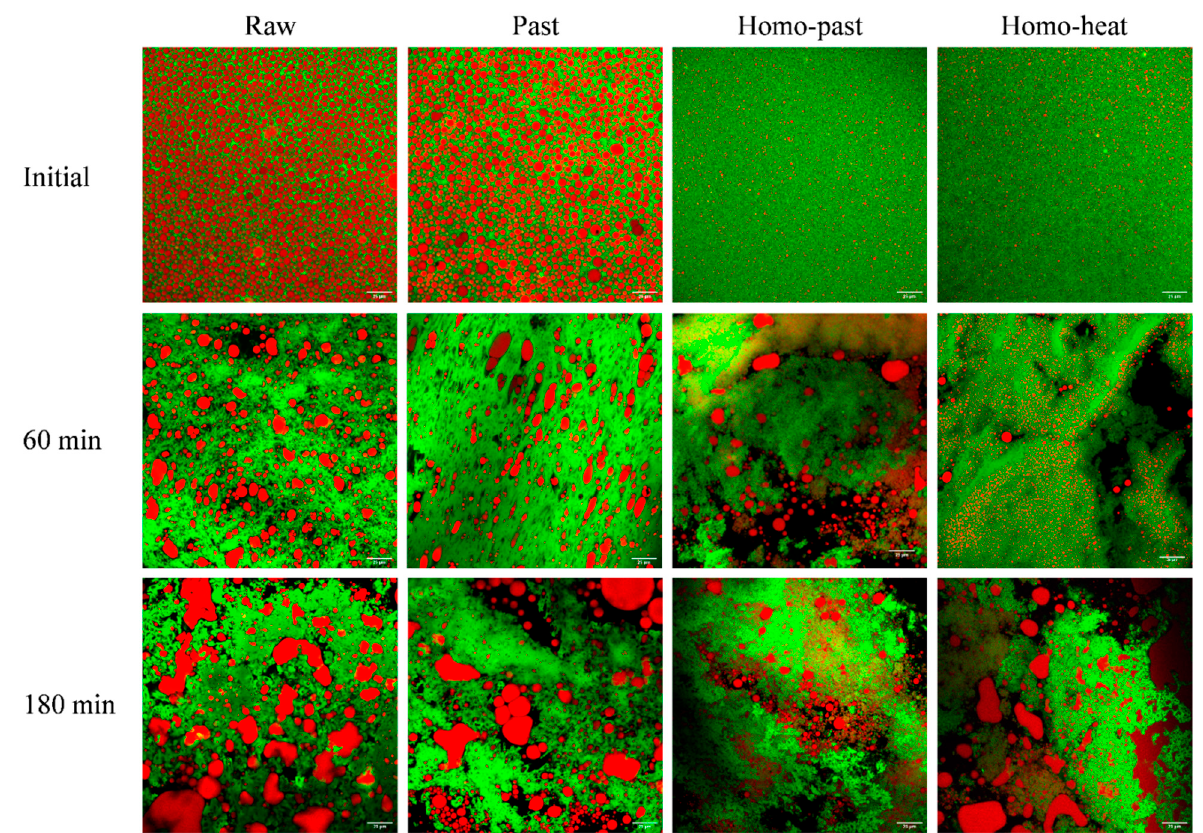
Figure 3. Confocal micrographs of curds obtained at 60 and 180 min during in vitro gastric digestion of raw, pasteurized (Past), homogenized and pasteurized (Homo–past), and homogenized and heated (Homo–heat) sheep milks. Red shows the fat and green shows the protein. The scale bar in all images is 25 μ m.